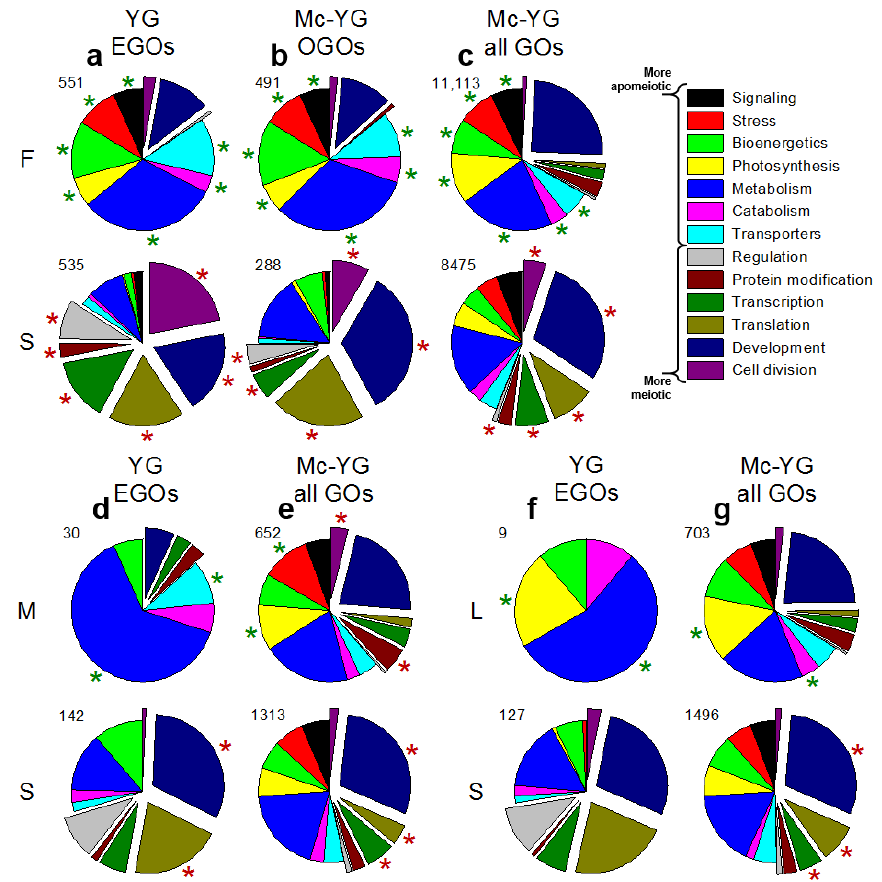
Figure 3. Pie charts of enriched gene ontology categories (EGOs), overexpressed GOs (OGOs), and GOs of di ff erentially expressed genes (all GOs) by GO group and by comparison: ( a – c ), F vs. S; ( d , e ), M vs. S; ( f , g ), L vs. S. F ( Boechera × formosa ), L ( Boechera lignifera ), M ( Boechera microphylla ), S ( Boechera stricta ), Mc (meiocyte stage), YG (young gametophyte stage). Normal and exploded subgroups tended to be more frequently observed in less and more meiotic taxa, respectively. Starred subgroups di ff ered significantly in frequency ( p ≤ 0.05): green stars, normal; red stars, exploded; values next to pies are total numbers of GOs observed.